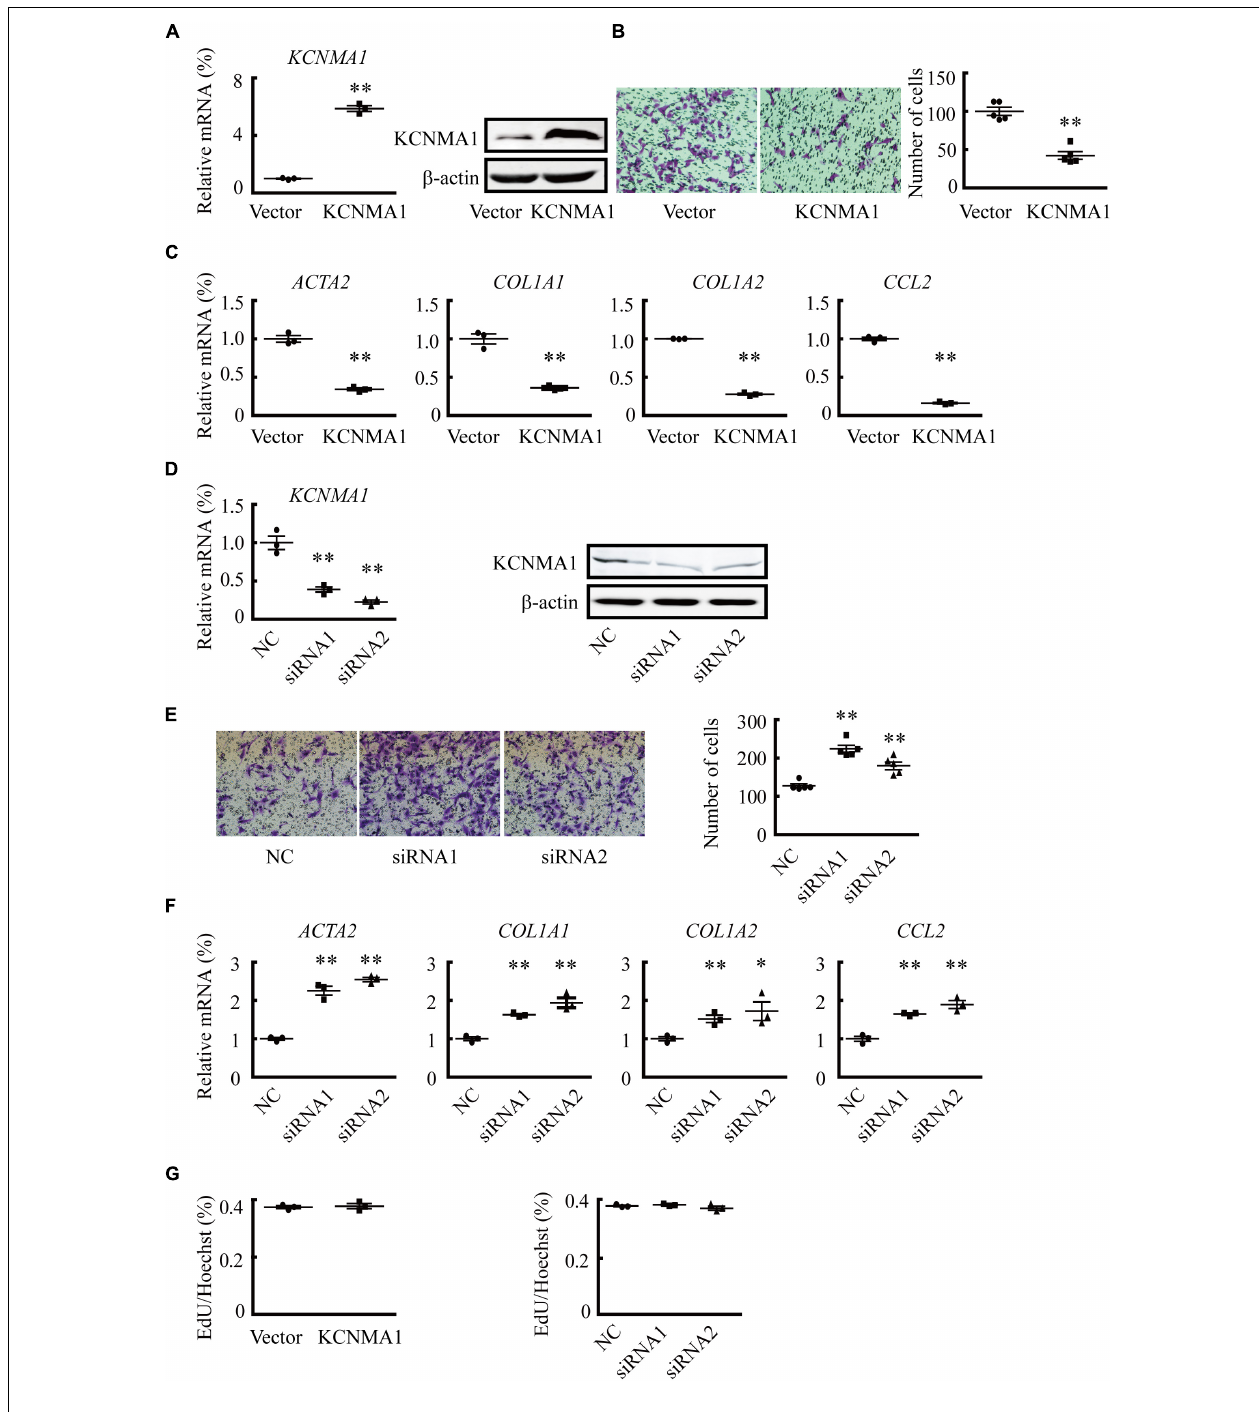
FIGURE 2 | Overexpression of the BK channel alpha subunit (KCNMA1) inhibits hepatic stellate cell (HSC) migration and fibrosis-related gene expression. (A) Validation of KCNMA1 overexpression by qPCR ( left ) and western blotting ( right ). (B) Representative images of cells ( left ) and average number of migrated cells ( right ) showing the inhibitory effects of transient KCNMA1 overexpression on LX2 cell migration. (C) Normalized mRNA expression of aortic smooth muscle actin ( ACTA2 ), collagen type I alpha 1 chain ( COL1A1 ), COL1A2 , and C-C motif chemokine ligand 2 ( CCL2 ) in LX2 cells pretreated with TGF β 1 after transfection with KCNMA1 -expressing plasmids. (D) Detection of KCNMA1 by qPCR ( left ) and western blotting ( right ) after siRNA transfection. (E) Representative images ( left ) and averaged number of migrated cells ( right ) showing the inhibitory effects of knocking down KCNMA1 on LX2 cell migration. (F) Normalized mRNA expression levels of ACTA2 , COL1A1 , COL1A2 , and CCL2 in LX2 cells pretreated with TGF β 1 after transfection with siRNA targeting KCNMA1. (G) Ratio of EdU-positive cells to Hoechst 33342-stained nuclei after transfection of KCNMA1 -expressing plasmids ( left ) or KCNMA1 siRNA ( right ) ( ∗ p < 0.05, ∗∗ p < 0.01 compared with the vector or negative control (NC)